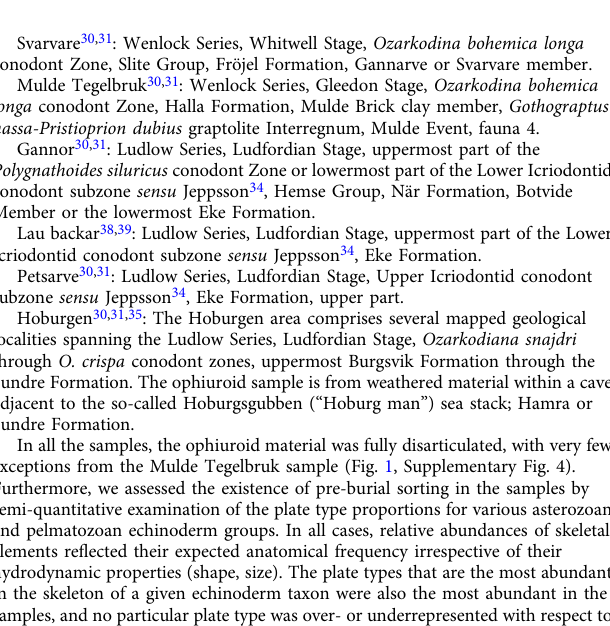
Fig. 4 Summary diagram of the Mulde Event (the “ Big Crisis ” 11 ) in the Silurian of Gotland, Sweden. Occurrences of the ophiuroid species O. paicei and M. haakei and biotic events are